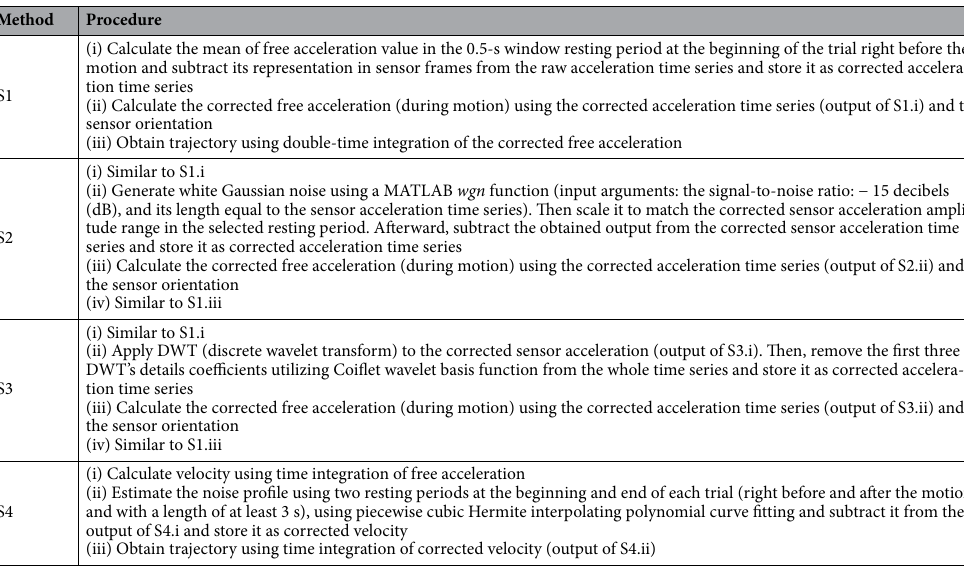
Table 2. The skater’s velocity and trajectory are obtained by time integration and double-time integration of the free acceleration obtained by the IMUs. Methods were originally proposed (S1–S4) to remove the drift in these integration